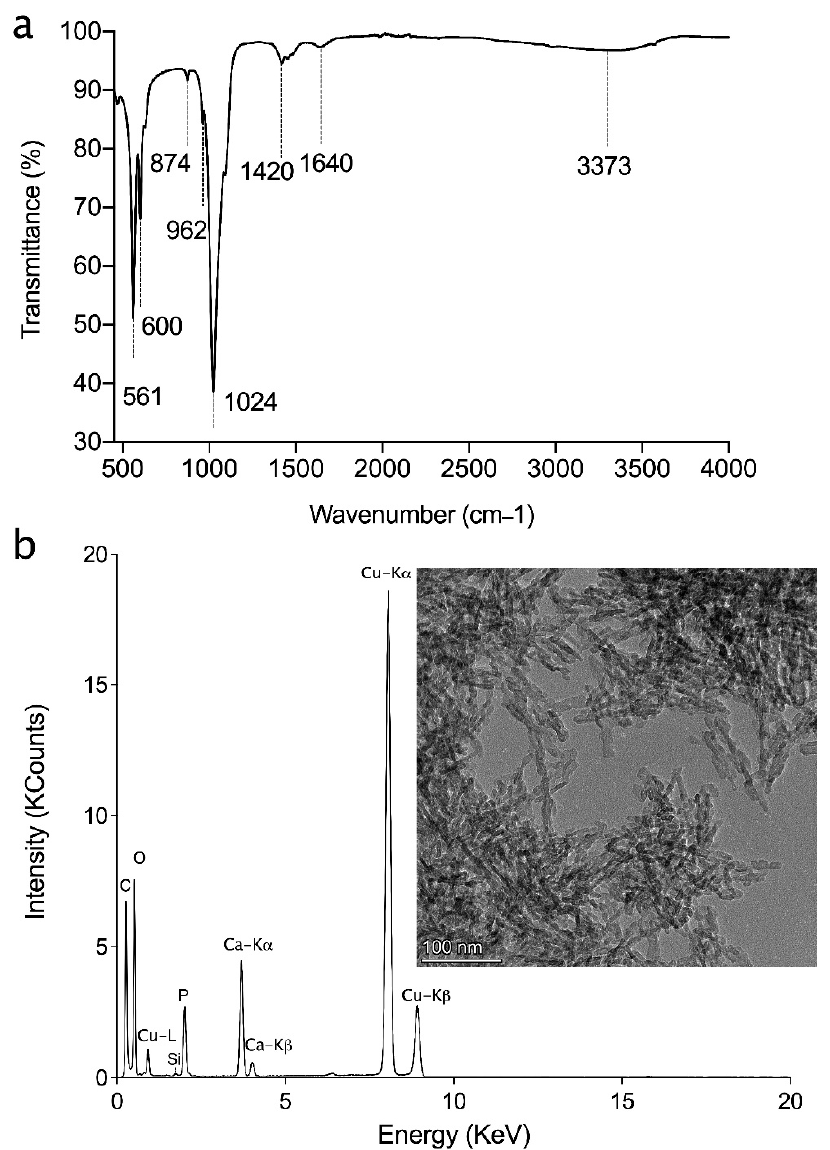
Figure 2. ( a ) FTIR spectra and ( b ) TEM image and its corresponding EDX analysis of synthesized nano HAp powder.